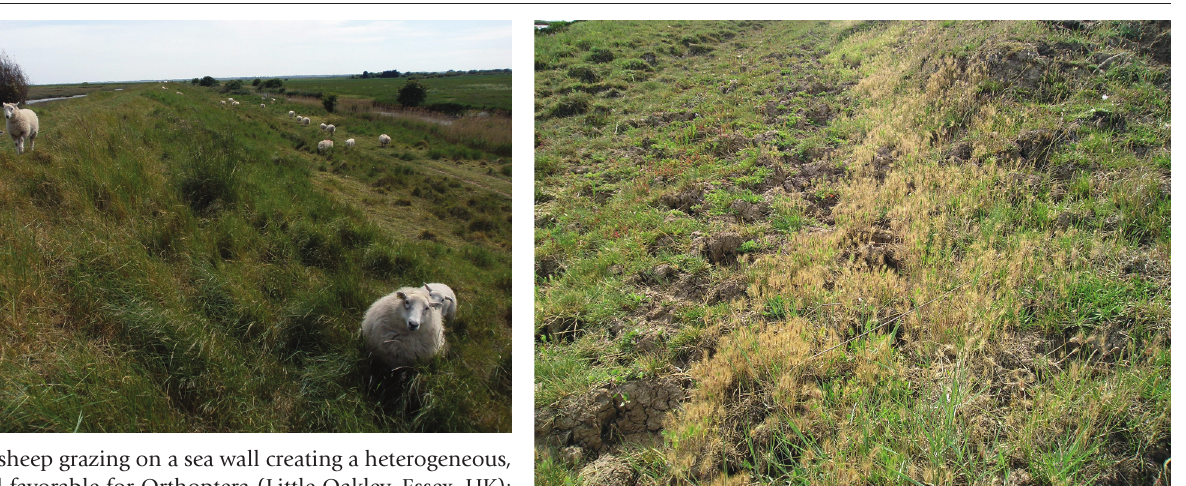
Fig. 6. Horse grazed area (left) vs. ungrazed area (right); credit T.